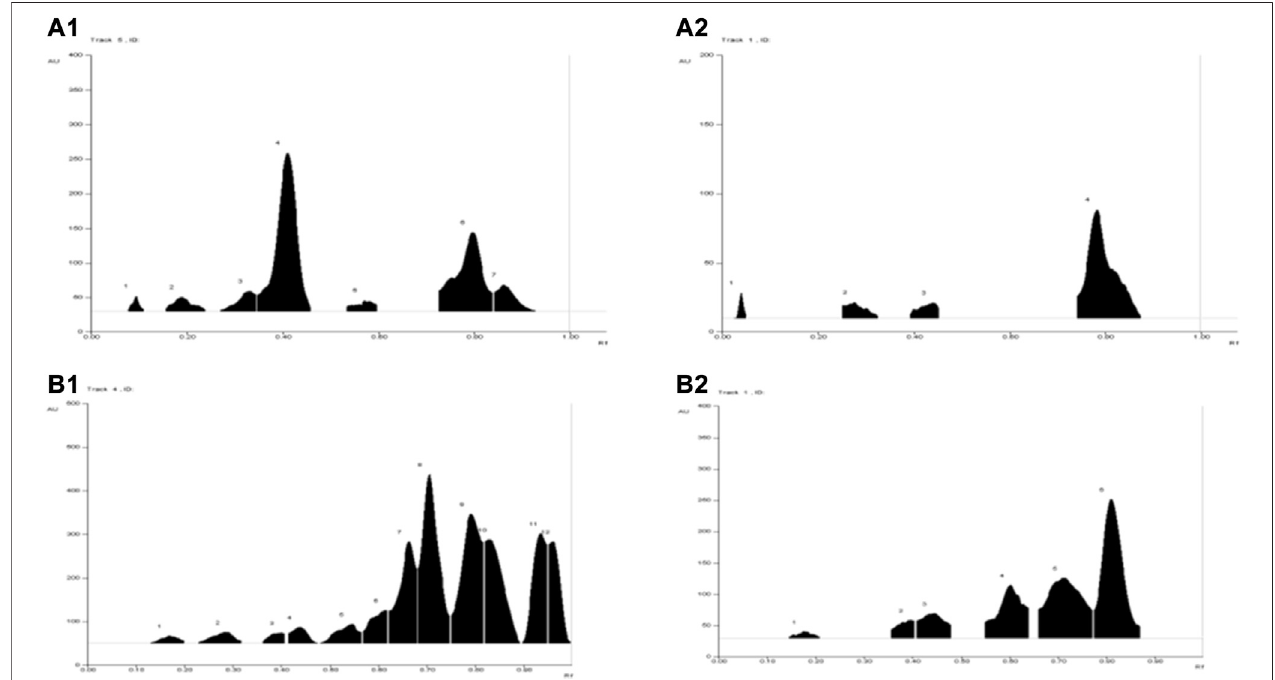
FIGURE2 | TLC chromatograms ofWSA and MFA at different wavelengths. (A1) WSA at 254 nm (A2) WSA at 366 nm (B1) MFA at 254 nm (B2) MFA at 366 nm.